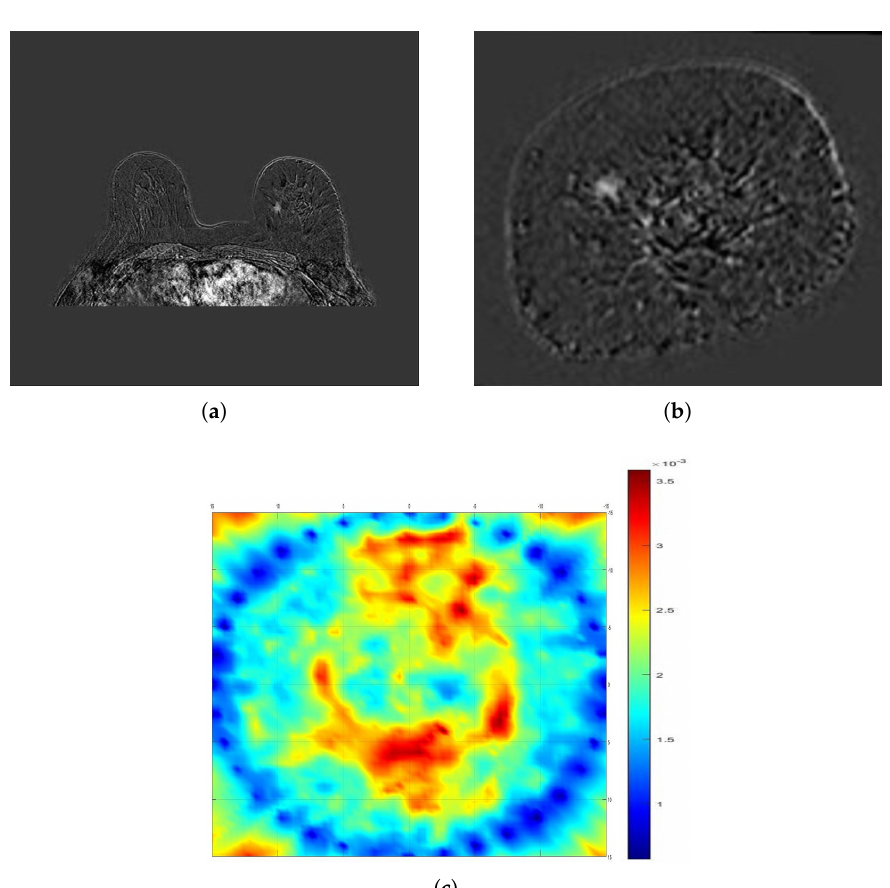
Figure 4. Comparison of SAFE image with clinical MRI: ( a , b ) MRI scans showing malignant lesion in the left breast (axial and coronal planes) and ( c ) SAFE scan showing no concordance with MRI (coronal plane) because of air gaps.